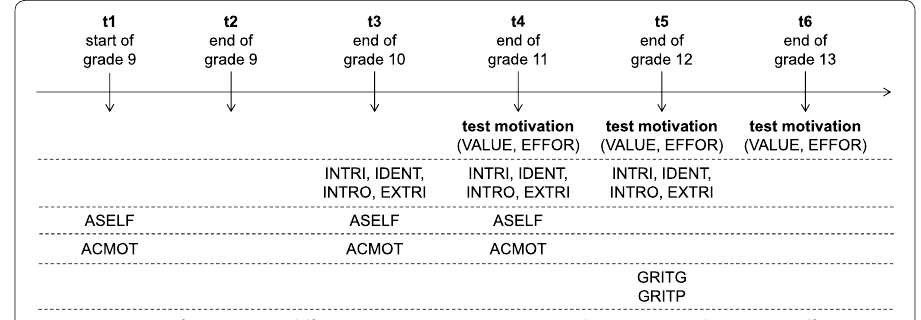
Fig. 5 Overview of measures at different occasions in time. VALUE, Subjective test value; EFFOR, Effort; INTRI, Intrinsic regulation; IDENT, Identified regulation; INTRO, Introjected regulation; EXTRI, External regulation; ACMOT, Achievement motivation; ASELF, Academic self-concept; GRITG, Passion for long-term goals; GRITP,